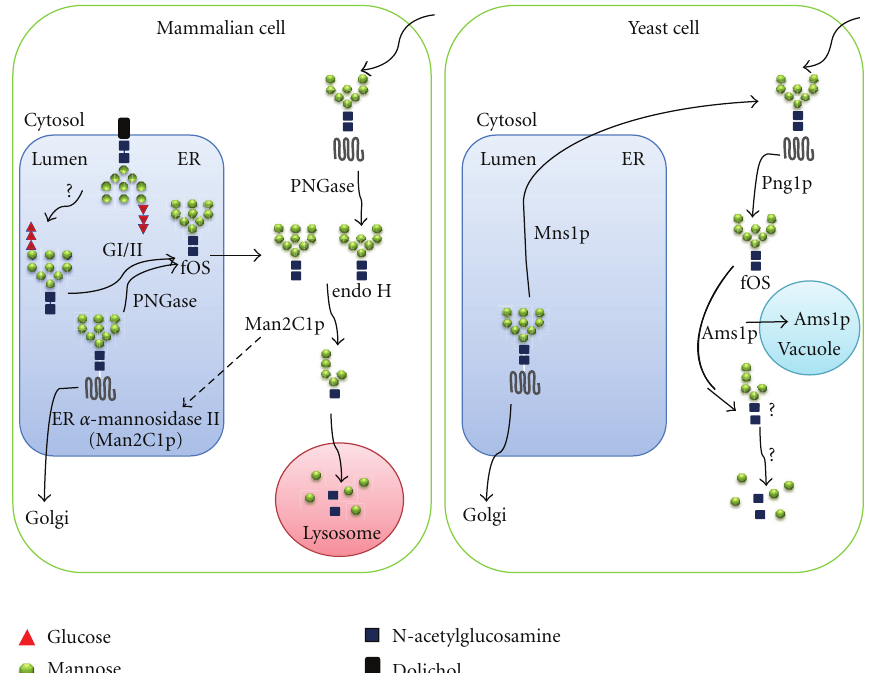
Figure 4: Comparison of free oligosaccharide catabolism in mammalian and yeast cells. Glycoprotein biosynthesis in mammalian cells is accompanied by the generation of free oligosaccharides (fOS) from both OST-mediated hydrolysis of Glc 3 Man 9 GlcNAc 2 -PP-dolichol in the lumen of the ER and peptide N-glycanase (PNGase-) mediated de-N-glycosylation of newly synthesized glycoproteins, which undergo ER associated protein degradation (ERAD), either in the ER or the cytosol. fOS that are liberated in ER can be transported into the cytosol. In the cytosol, fOS are trimmed by an endo- β -D- N- acetylglucosamine H (endo H-) like enzyme and the α -mannosidase Man2C1p to yield Man 5 GlcNAc, which can be imported directly into lysosomes to be degraded. In S. cerevisiae , fOS are released from glycoproteins in the cytosol by Png1p, a counterpart of mammalian PNGase. Then the Png1p-generated fOS may be processed in the cytosol by Ams1p, the yeast cytosolic α -mannosidase. It should also be noted that no structural studies have been performed on the products that can be generated from Man 8 GlcNAc 2 by Ams1p, and the ultimate fate of such products remains obscure. On the other hand, two Png1p-independent fOS pools, Man 3 GlcNAc 2 and Man 8 GlcNAc 2 , are also seen in S. cerevisiae . The pool comprising small fOS (Man 3 GlcNAc 2 ) appears to be disposed of